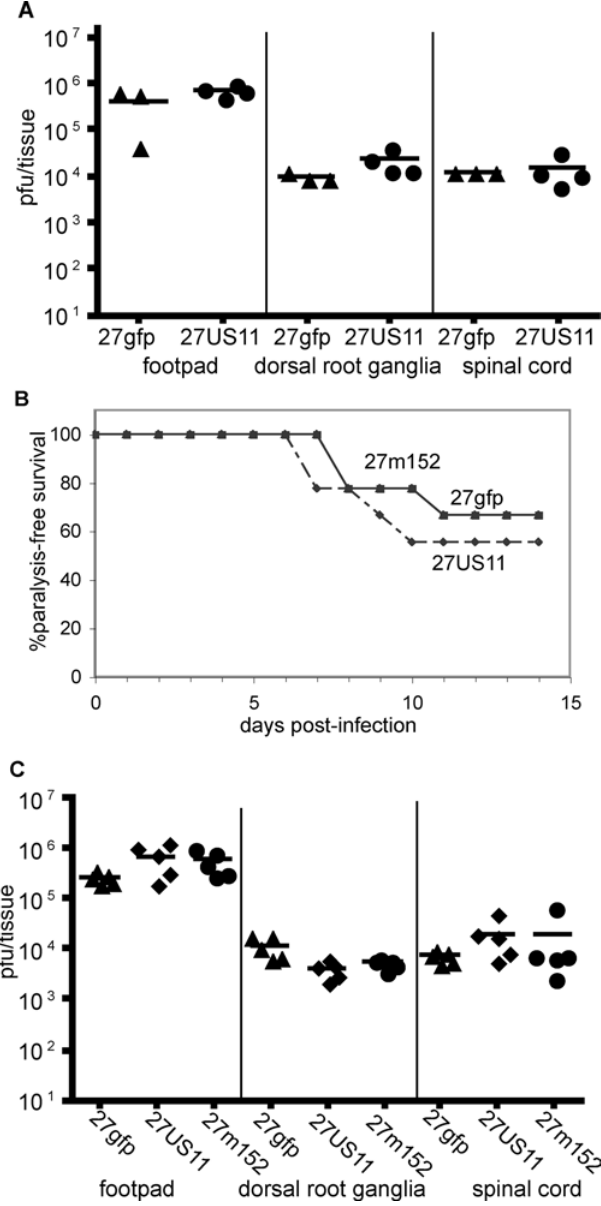
Figure 7. Differences in Neuroinvasiveness and Neurovirulence Are Dependent on MHC Class I and CD8 T Cells (cid:1) / (cid:1) BALB/c mice were infected in the hind footpads with 3.0 3 10 4 b 2 m pfu of 27gfp, 27US11, or 27m152. Note that a lower inoculum was used in these experiments with b 2 m (cid:1) / (cid:1) mice than in wild-type BALB/c mice shown in other figures. (A) The indicated tissues were isolated on day 6, homogenized, and viral titers were determined on vero cells. (B) Nine mice per virus were monitored for paralysis induction for 14 d. Mice displaying ataxia or paralysis were euthanized. (C) BALB/c mice were depleted of CD8 cells and infected with 2.5 3 10 5 pfu of the indicated virus in the hind footpads. Viral titers were determined on day 6. DOI: 10.1371/journal.ppat.0010007.g007